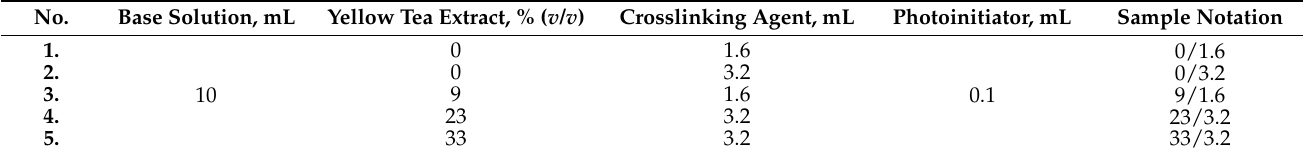
Table 1. Compositions of synthesized hydrogels.